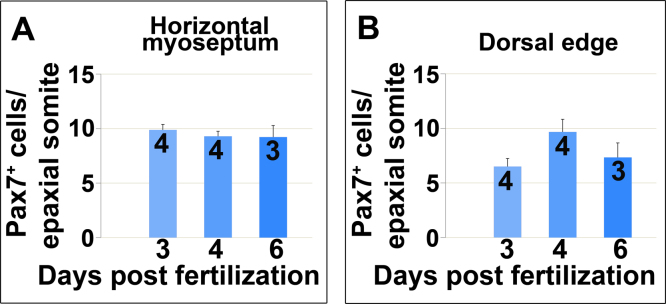
Quantitation of the number of Pax7+ cells at horizontal myoseptum and dorsal edge. Mean count of Pax7+ cells in horizontal myoseptum (A) and dorsal edge (B) domains of somites 16–18 in the number of fish indicated on the columns. No difference was significant.